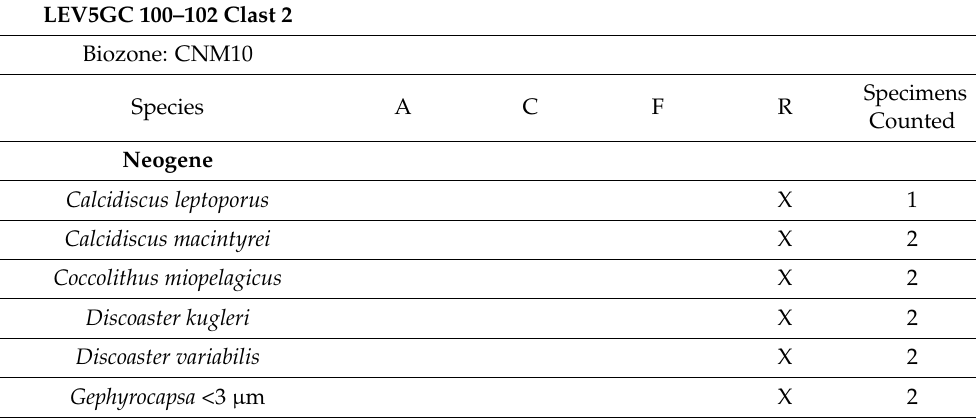
Table A25. Moscow